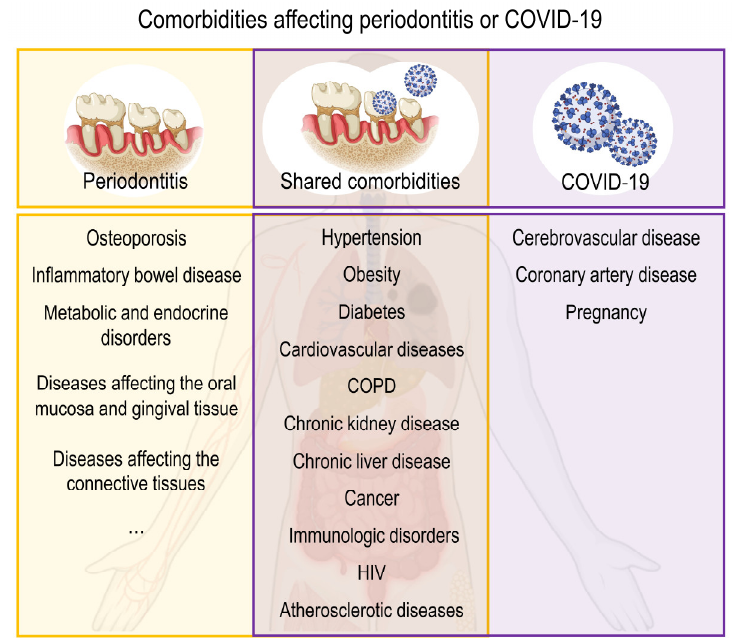
Figure 4. The comorbidities and shared comorbidities of periodontitis and COVID-19.